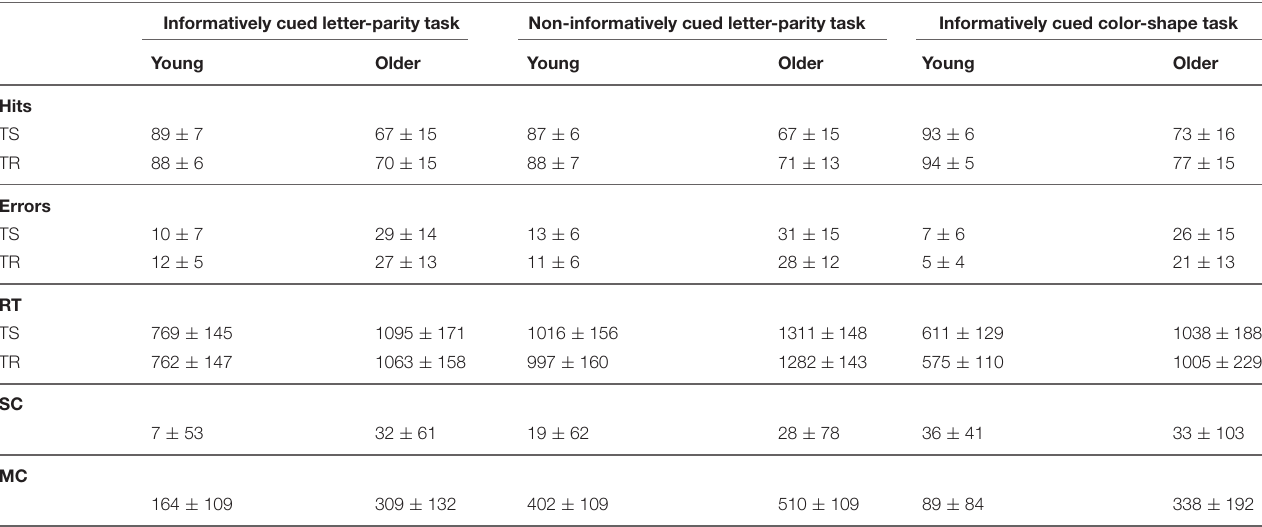
TABLE 2 | Hits (%), errors (%) and reaction time (RT, in ms) for switch (TS) and repeat (TR) trials; switching costs (SC, in ms) and mixing costs (MC, in ms) are summarized with their mean and standard deviation for the age groups in the three TS paradigms. Informatively cued letter-parity